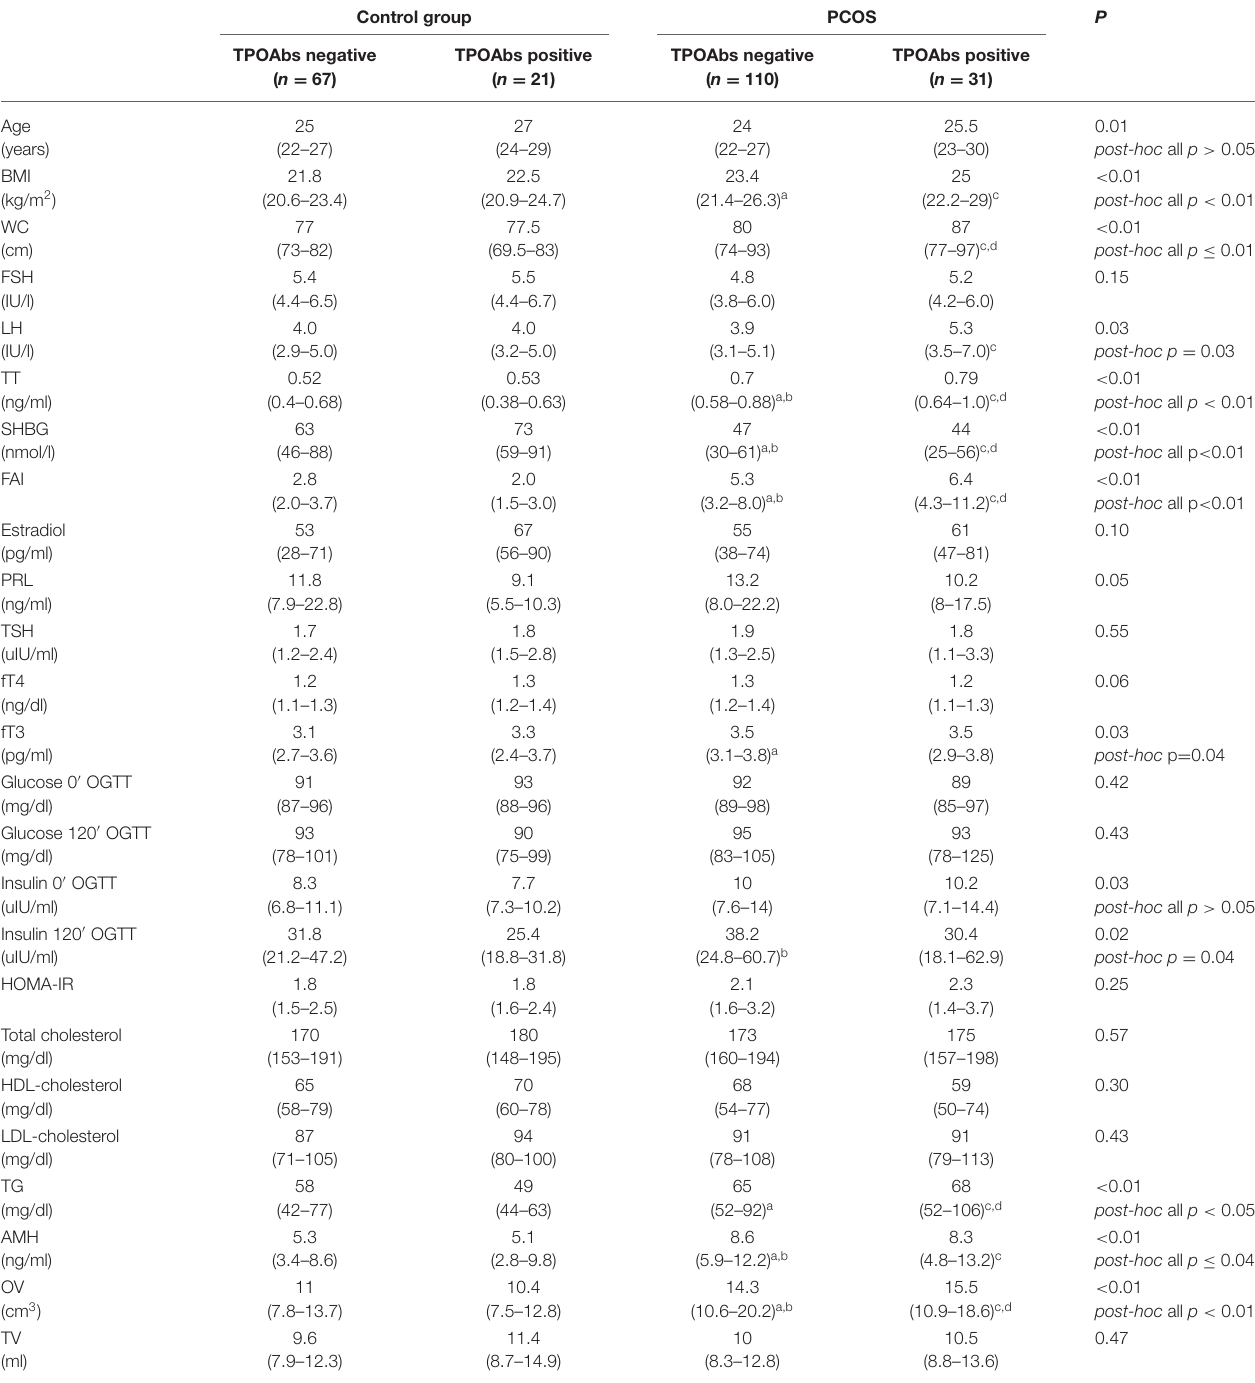
TABLE 2 | Comparison of clinical, biochemical, and hormonal parameters of PCOS patients and the control group based on the TPOAbs status. Control